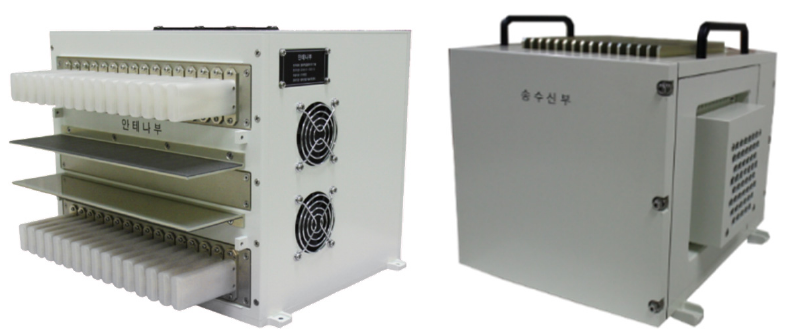
Figure 10. Antenna and Transceiver.